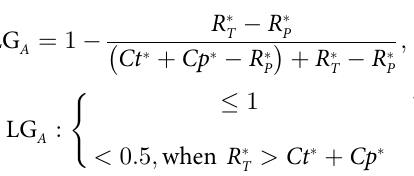
Fig 5. Phosphorylation and dephosphorylation cycles in a typical TCS limit the bistability range. (A) A schematic of the phosphorylation module. Autophosphorylation and auto-dephosphorylation of the HK are treated as pseudo first-order reversible reactions. The phosphotransferase and phosphatase activities of the bifunctional HK are modeled with Michaelis Menten kinetics. (B) Effects of the phosphorylation capacity Cp � on the logarithmic gain LG lines) and phosphorylation levels of RR R P � (dashed lines). All curves are modeled with Ct � = 1. The gray line indicates = 0.5; it intersects LG curves at Cp � + Ct � . Higher Cp � values allow higher phosphorylation levels and larger LG A A ranges in which LG A remains high. (C and D) Dependence of the fraction of phosphorylated RR (C) and LG A (D) on Cp � and total TF level. Low LG A values ( < 0.5, gray) can lower the overall logarithmic gain, limiting the bistability of the autoregulation